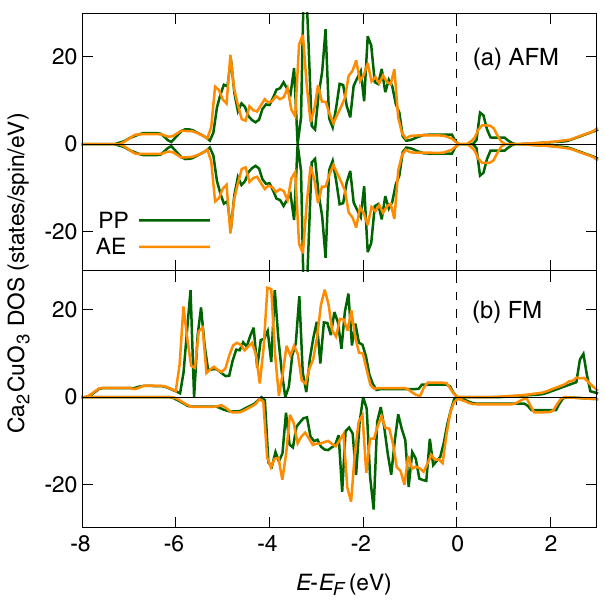
FIG. 2. The comparison of the Ca 2 CuO 3 densities of states (DOS) calculated using PP and AE codes: (a) antiferromagnetic and (b) ferromagnetic states. Energies are measured relative to